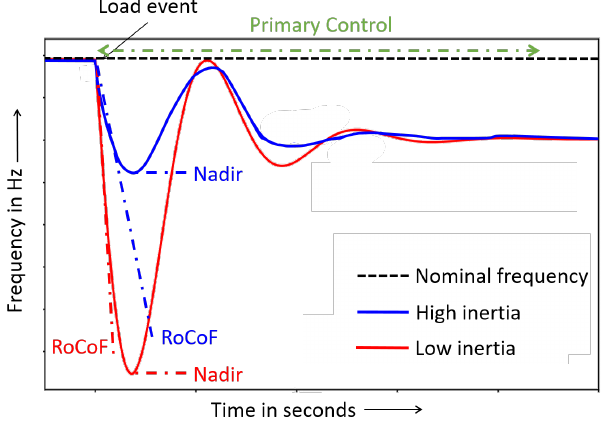
Figure 7. Frequency response with high and low